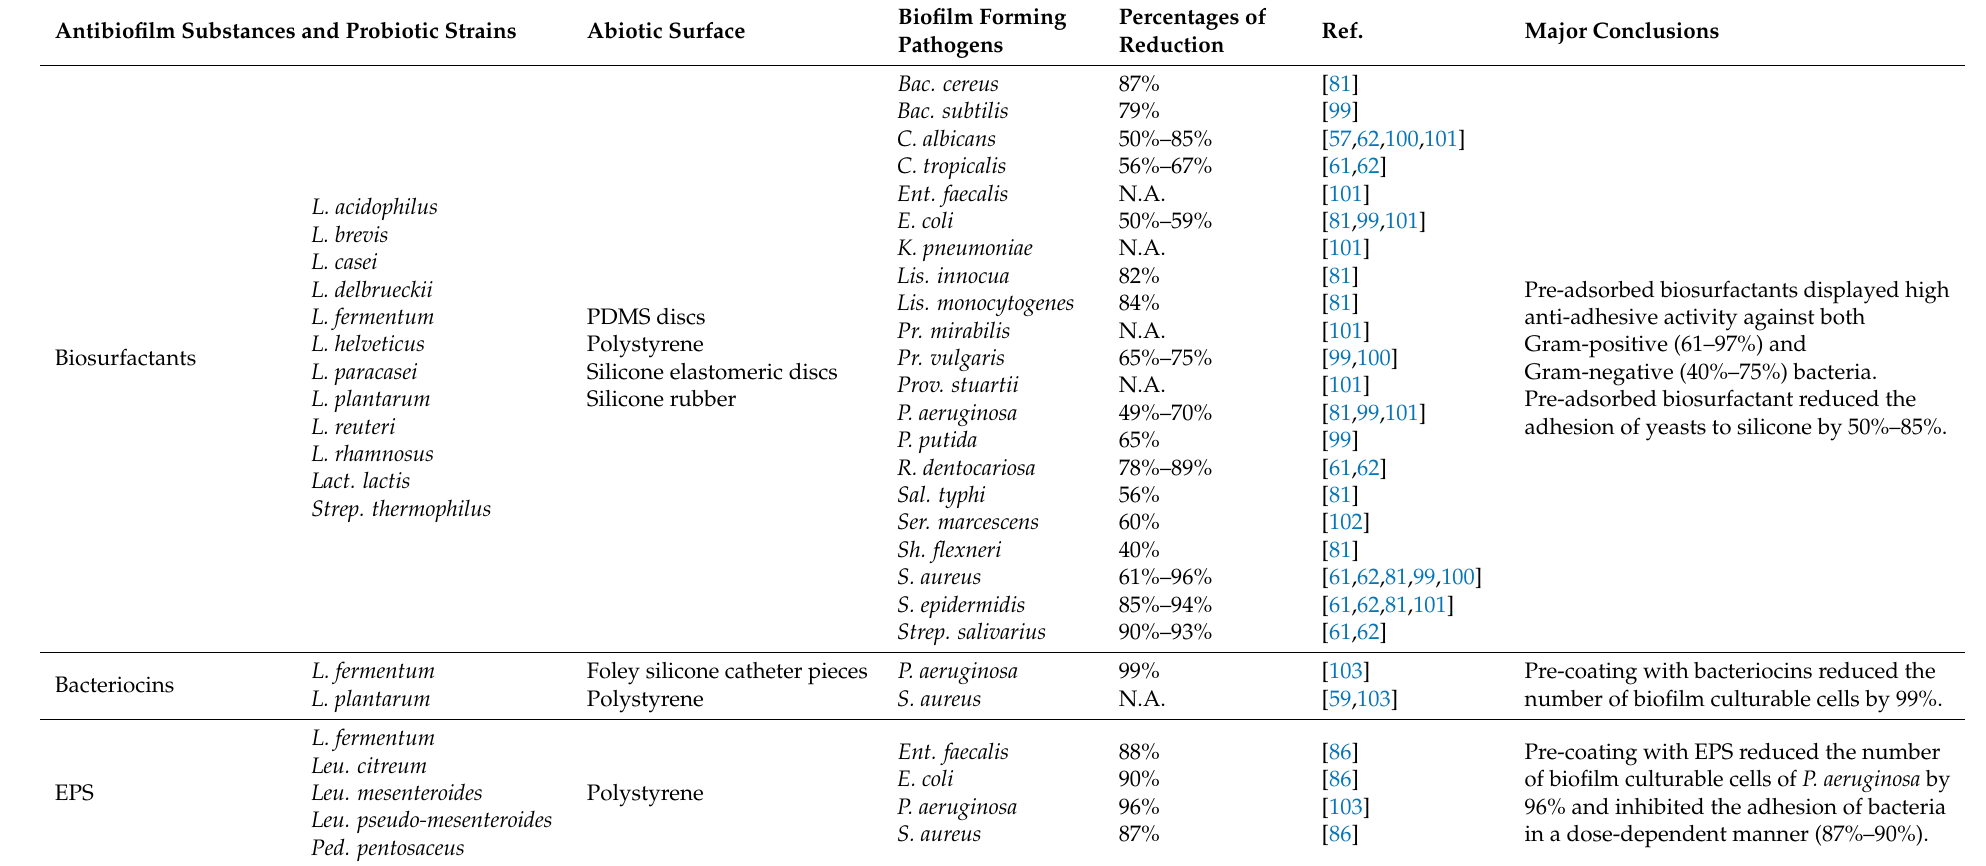
Table 2. Exclusion studies in medical